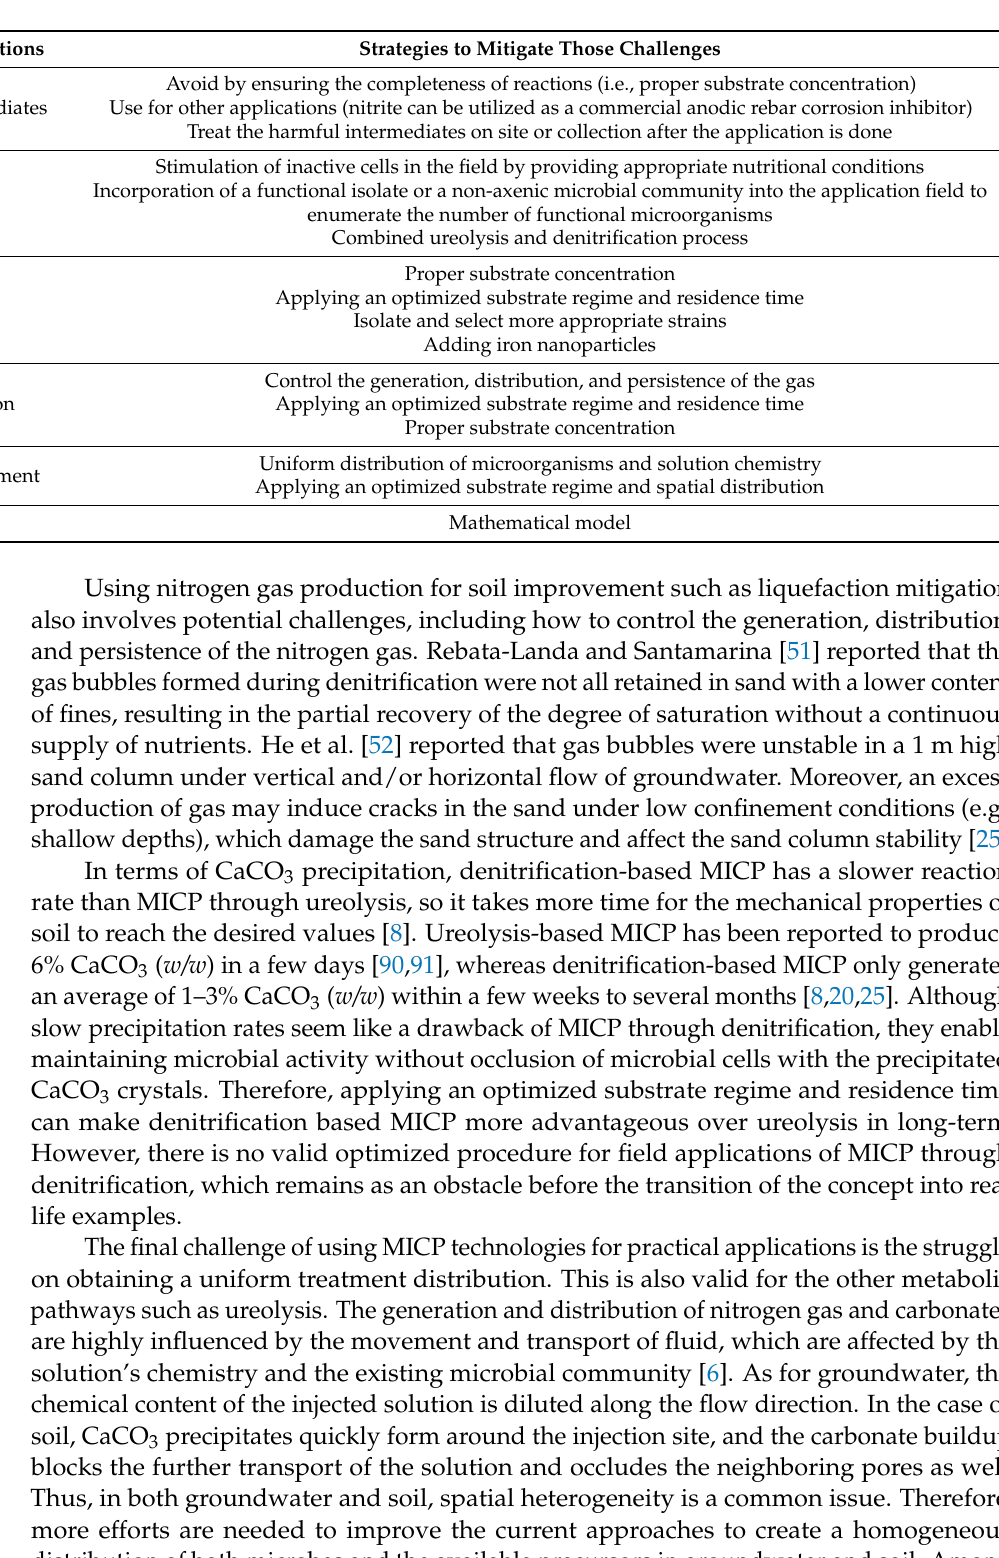
Table 5. Challenges faced in the real application of MICP and MIDP through denitrification, and the strategies to mitigate those